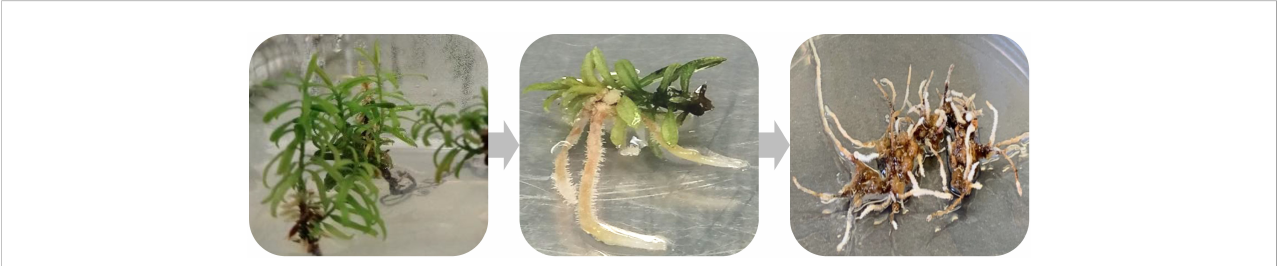
FIGURE 2 Summarized process of Taxus hairy roots induction and culture. The left image shows 8-week-old T. baccata seedlings grown in hormone-free DCR medium, these seedling were infected with Agrobacterium rhizogenes. The middle image shows the development of hairy roots at the infection site. The right image shows a stable, 1-year-old hairy root line isolated from the infected